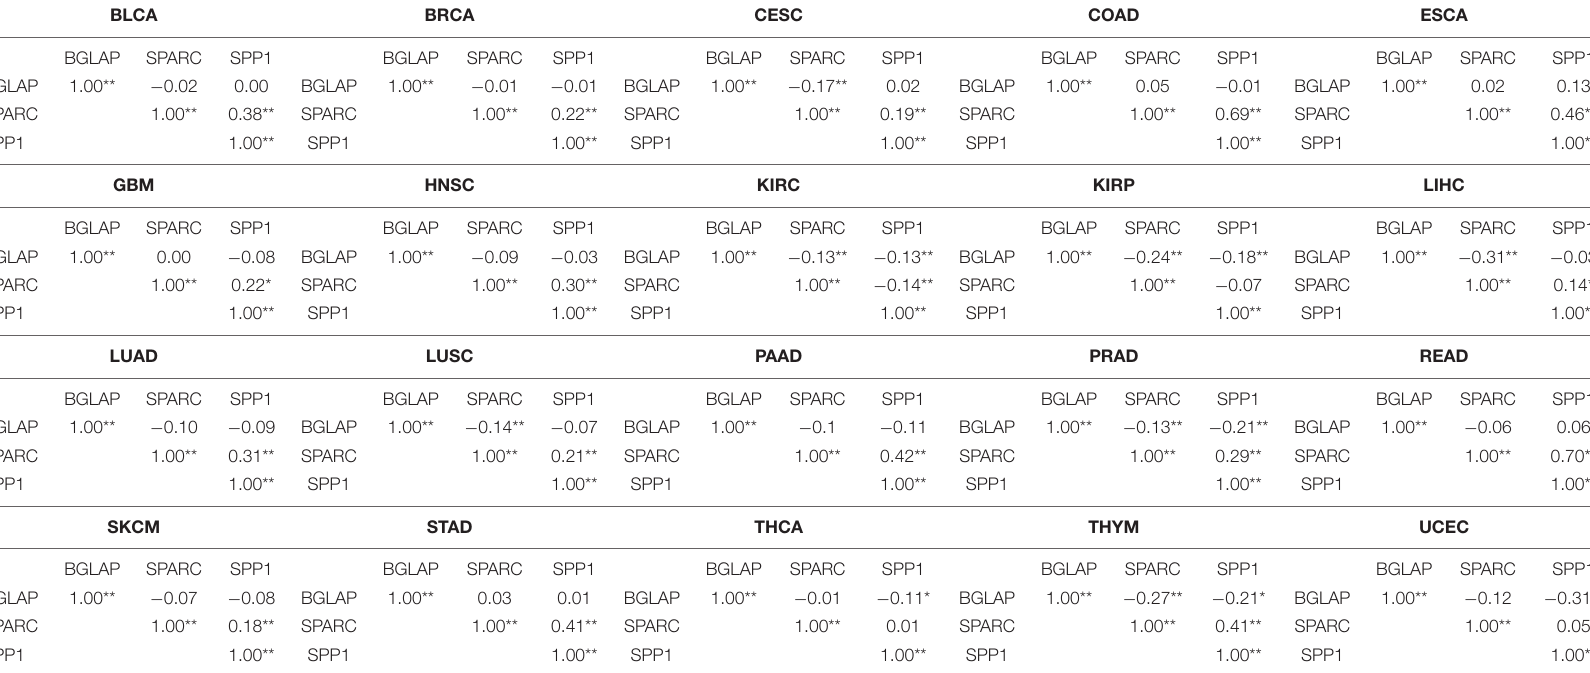
TABLE 1 | Correlations between the expression level of BGLAP, SPARC, and SPP1 in different cancer